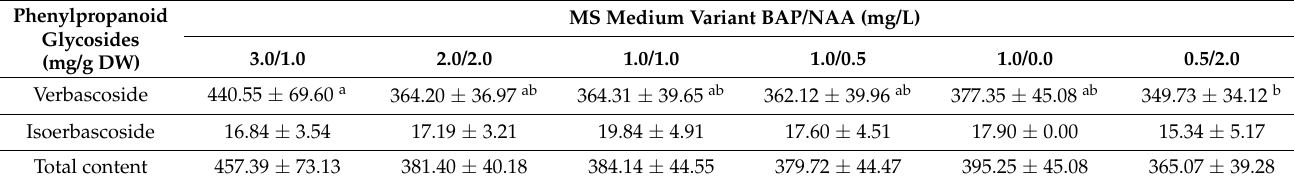
Table 4. Phenylpropanoid glycosides content in biomass extracts of Scutellaria brevibracteata subsp. subvelutina in vitro cultures (MS medium variants with BAP and NAA; 4-week growth